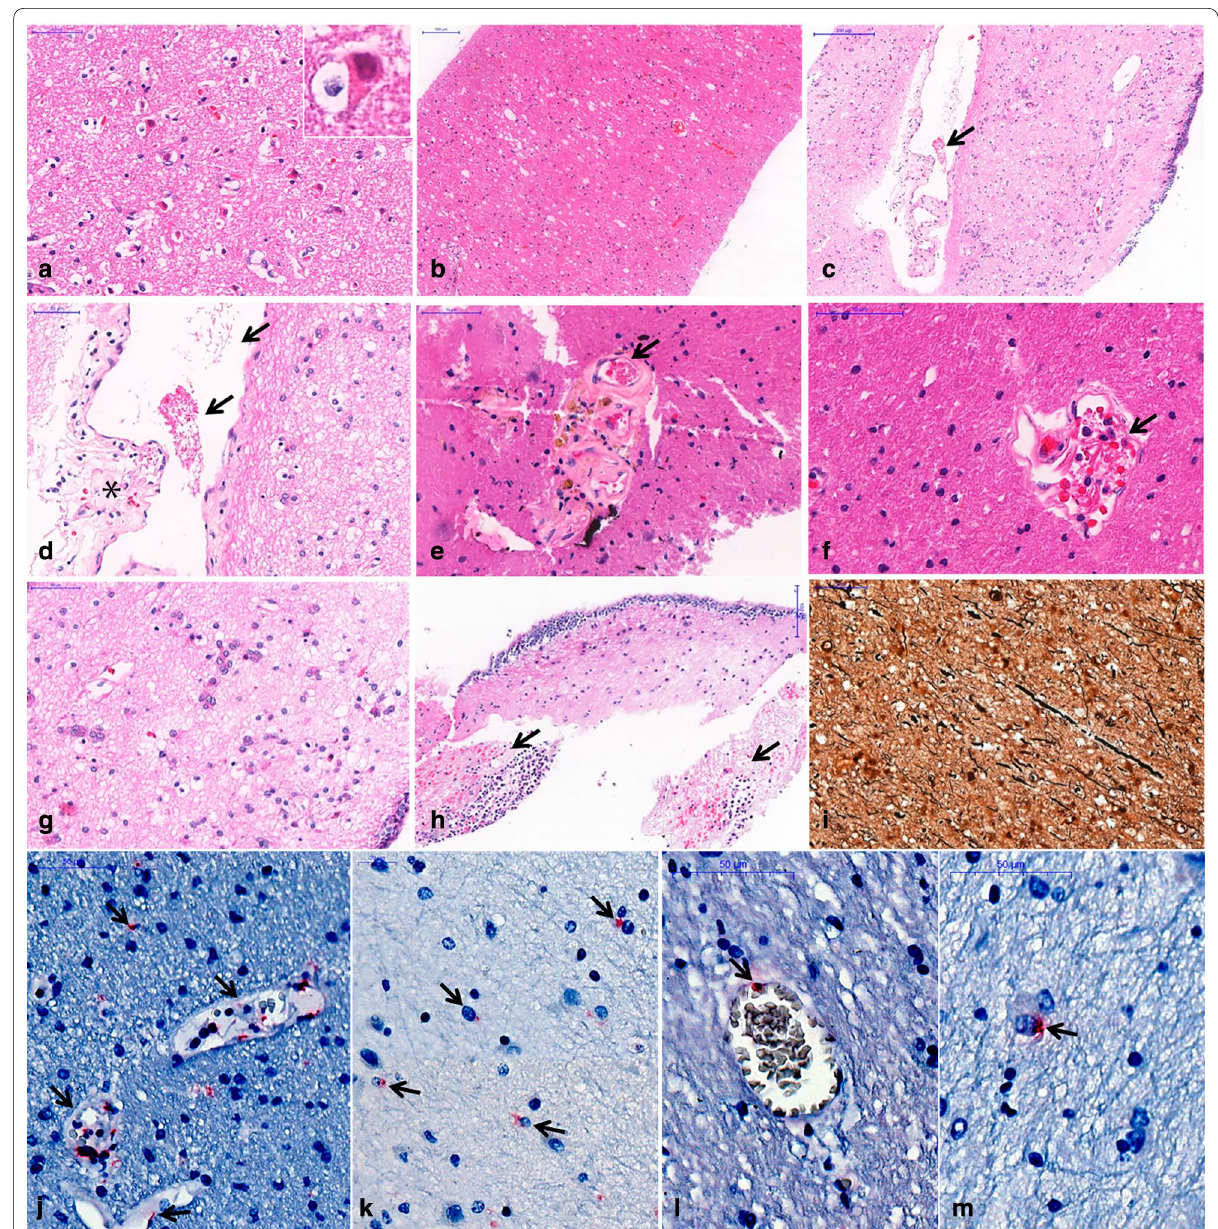
Fig. 6 Histological findings in the brain in six fatal COVID‑19 cases. a Eosinophilic degeneration of cortical neurons (“red neurons”) secondary to hypoxia; b white matter edema and congestion; c , d periventricular vessel with small fibrin clot (arrows), perivascular edema and red cells perivascular leakage (asterisk); e fibrin clot within (arrow) a vessel with lipohyalinosis and perivascular hemosiderin deposits, compatible with previous small vessel disease and cerebral microhemorrhages; f fibrin within a vessel with perivascular edema and discrete perivascular bleeding (arrow); g Alzheimer type II glia in periventricular area; h foci of periventricular neutrophilic infiltrate and recent hemorrhages (arrows); i Bielschowsky’s silver stain revealing axonal disruption and thickening. j – m Immunohistochemistry reaction detected SARS‑CoV‑2 nucleocapsid protein in the cytoplasm of endothelial cells ( j , l ) and microglial cells ( k , m ), (arrows), (alkaline phosphatase). a–h : H&E